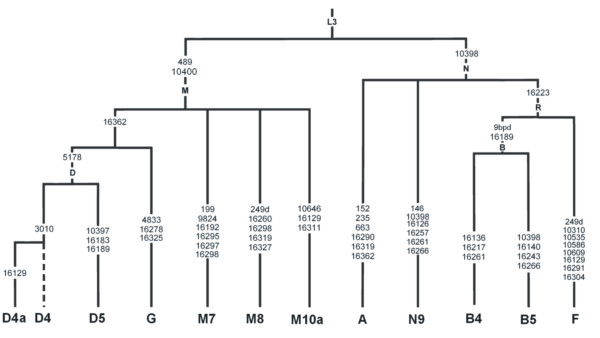
Classification of 12 mtDNA haplogroups in subjects of three case-control studies. The defining sites[38] (as compared with the revised CRS) utilized in this study are listed in the branches. "d" indicates a deletion; "9 bpd" indicates a 9 bp deletion in the intergenic mtDNA region between nucleotides 8195-8316[53].